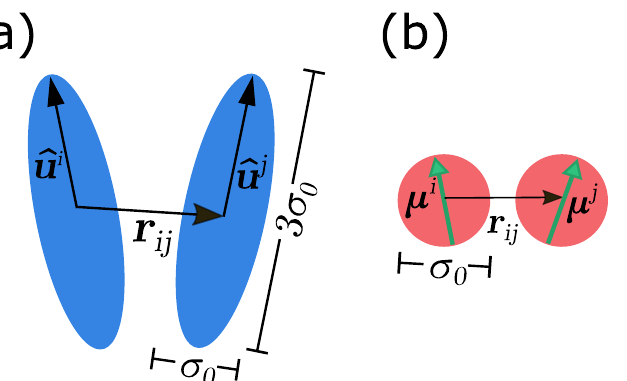
Figure 1. Panel ( a ): a sketch of the two ellipsoids separated by the distance r ij . The unit vectors ˆ u i and ˆ u j along the major axis of the ellipsoids represent their orientation. The width of an ellipsoid, σ 0 , defines the unit of the length. In order to set the aspect ratio equal to 3, the end-to-end length of an ellipsoid is taken to be equal to 3 σ 0 . Panel ( b ): the schematic diagram showing two dipolar soft spheres with embedded permanent dipole moment represented by vectors µ i and µ j . The vector r ij denotes the center-to-center distance between the two dipolar soft spheres. The diameter of the DSS is considered to be equal to σ 0 , the width of the